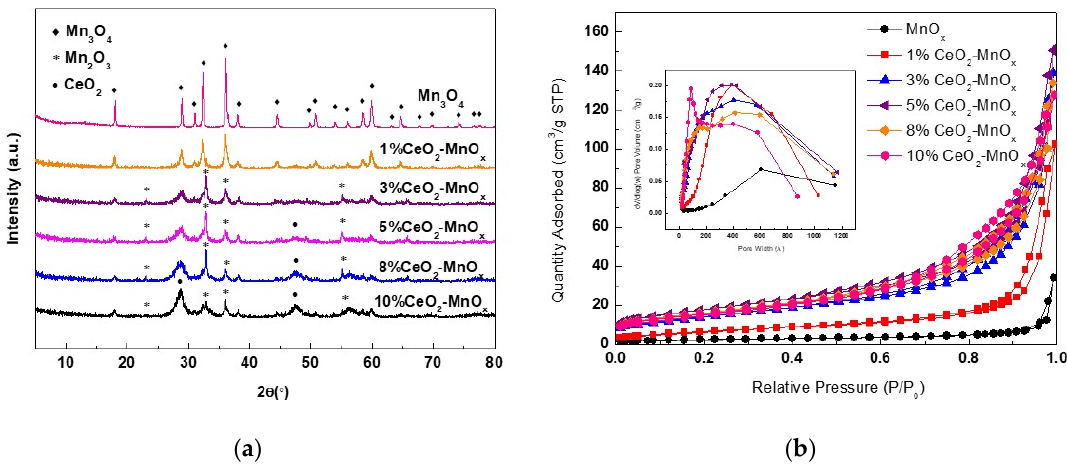
Figure 3. ( a ) Powder X-ray diffraction (XRD) and ( b ) N 2 sorption isotherms of w CeO 2 –MnO X .